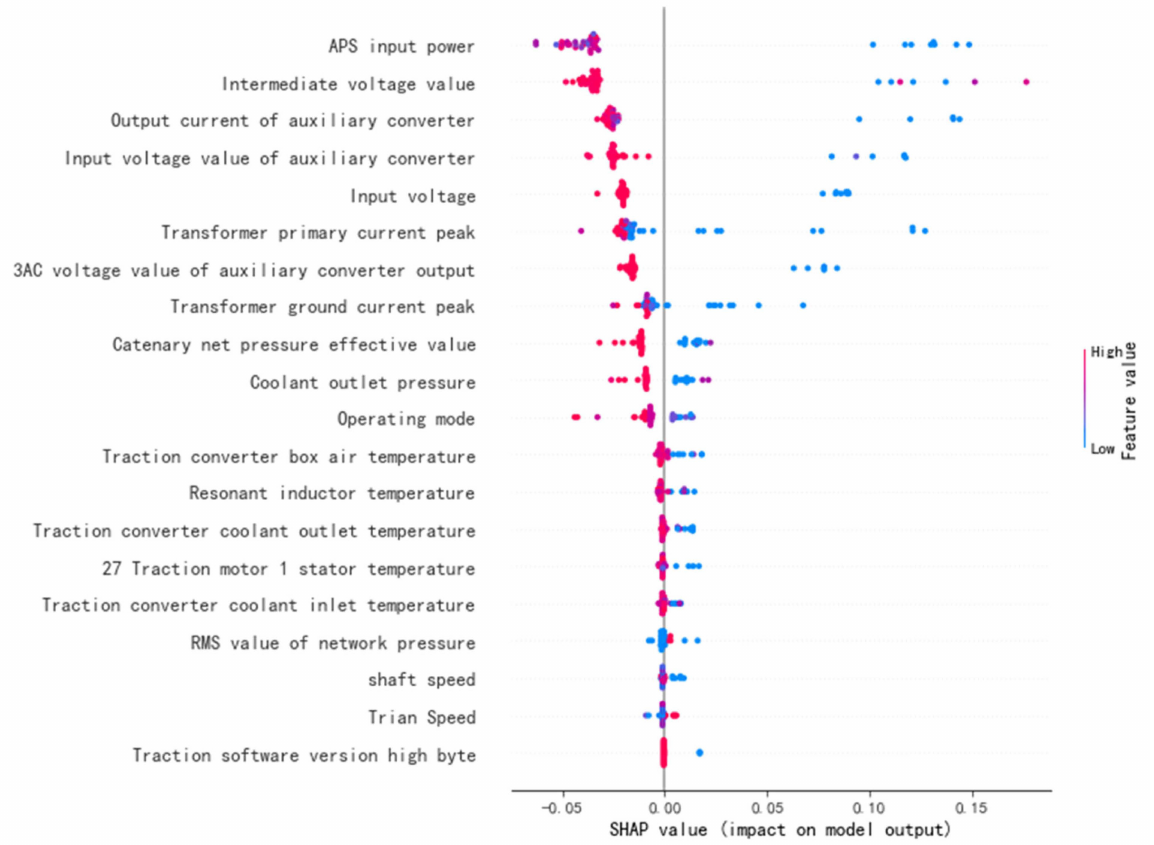
Figure 8. A visualization of the SHAP value of each feature